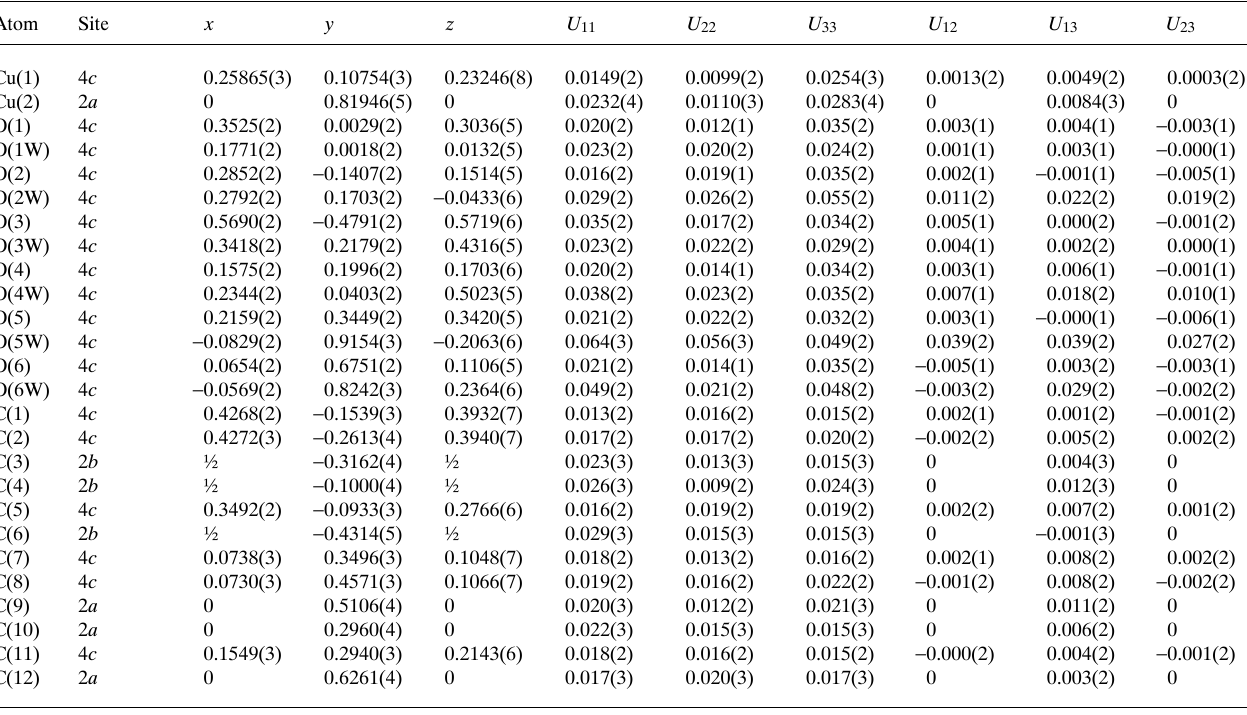
Table 3. A tomic coordin a tes a nd displ a cement p a r a meters (in Å 2 )